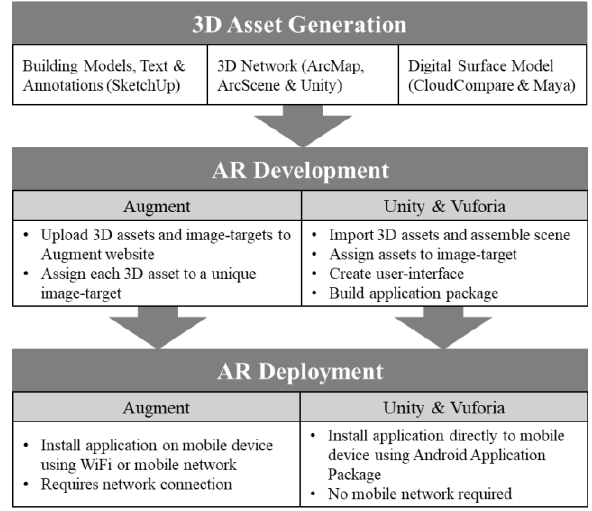
Figure 1. The workflow used to create the presented